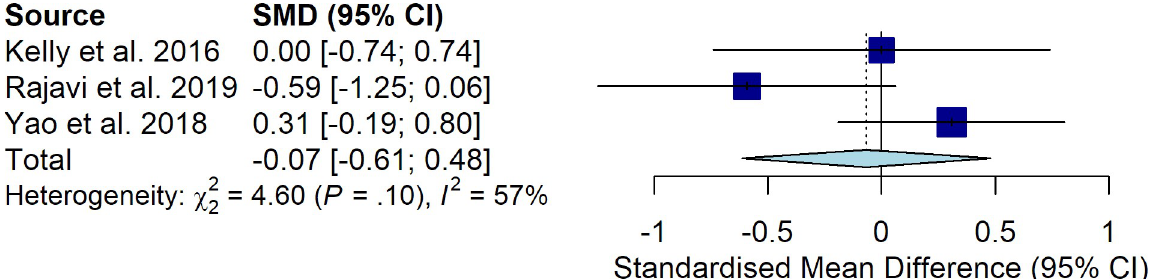
Fig 3. Difference in stereopsis between patients treated with binocular treatment versus